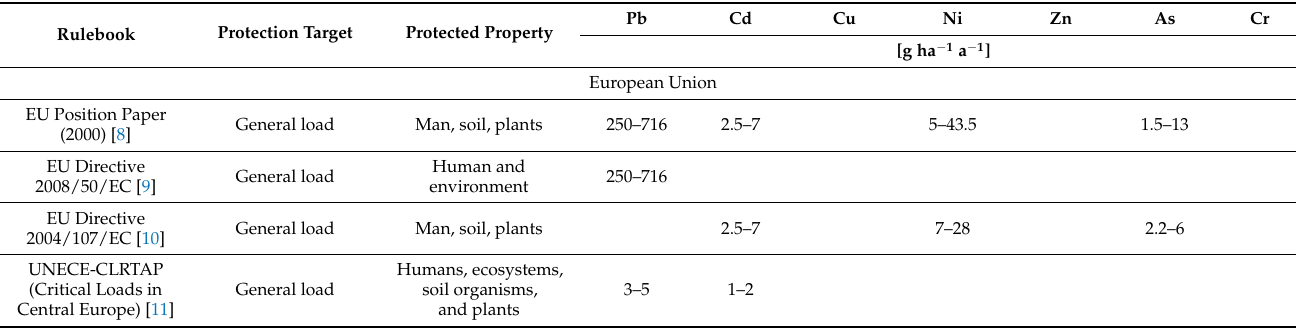
Table 1. Comparison of assessment values from legal and sublegal regulations in Western Europe, critical depositions after conversion by means of deposition rates according to Schaap et al.